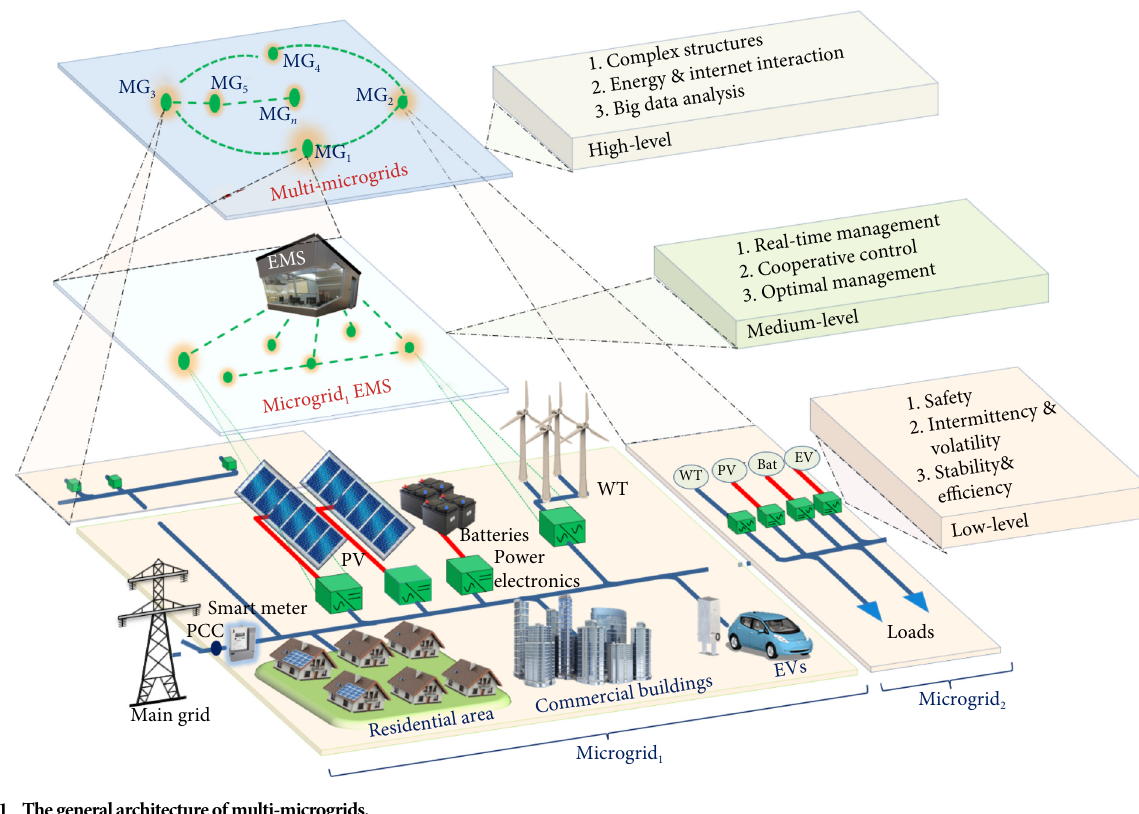
Fig. 1 The general architecture of multi-microgrids.